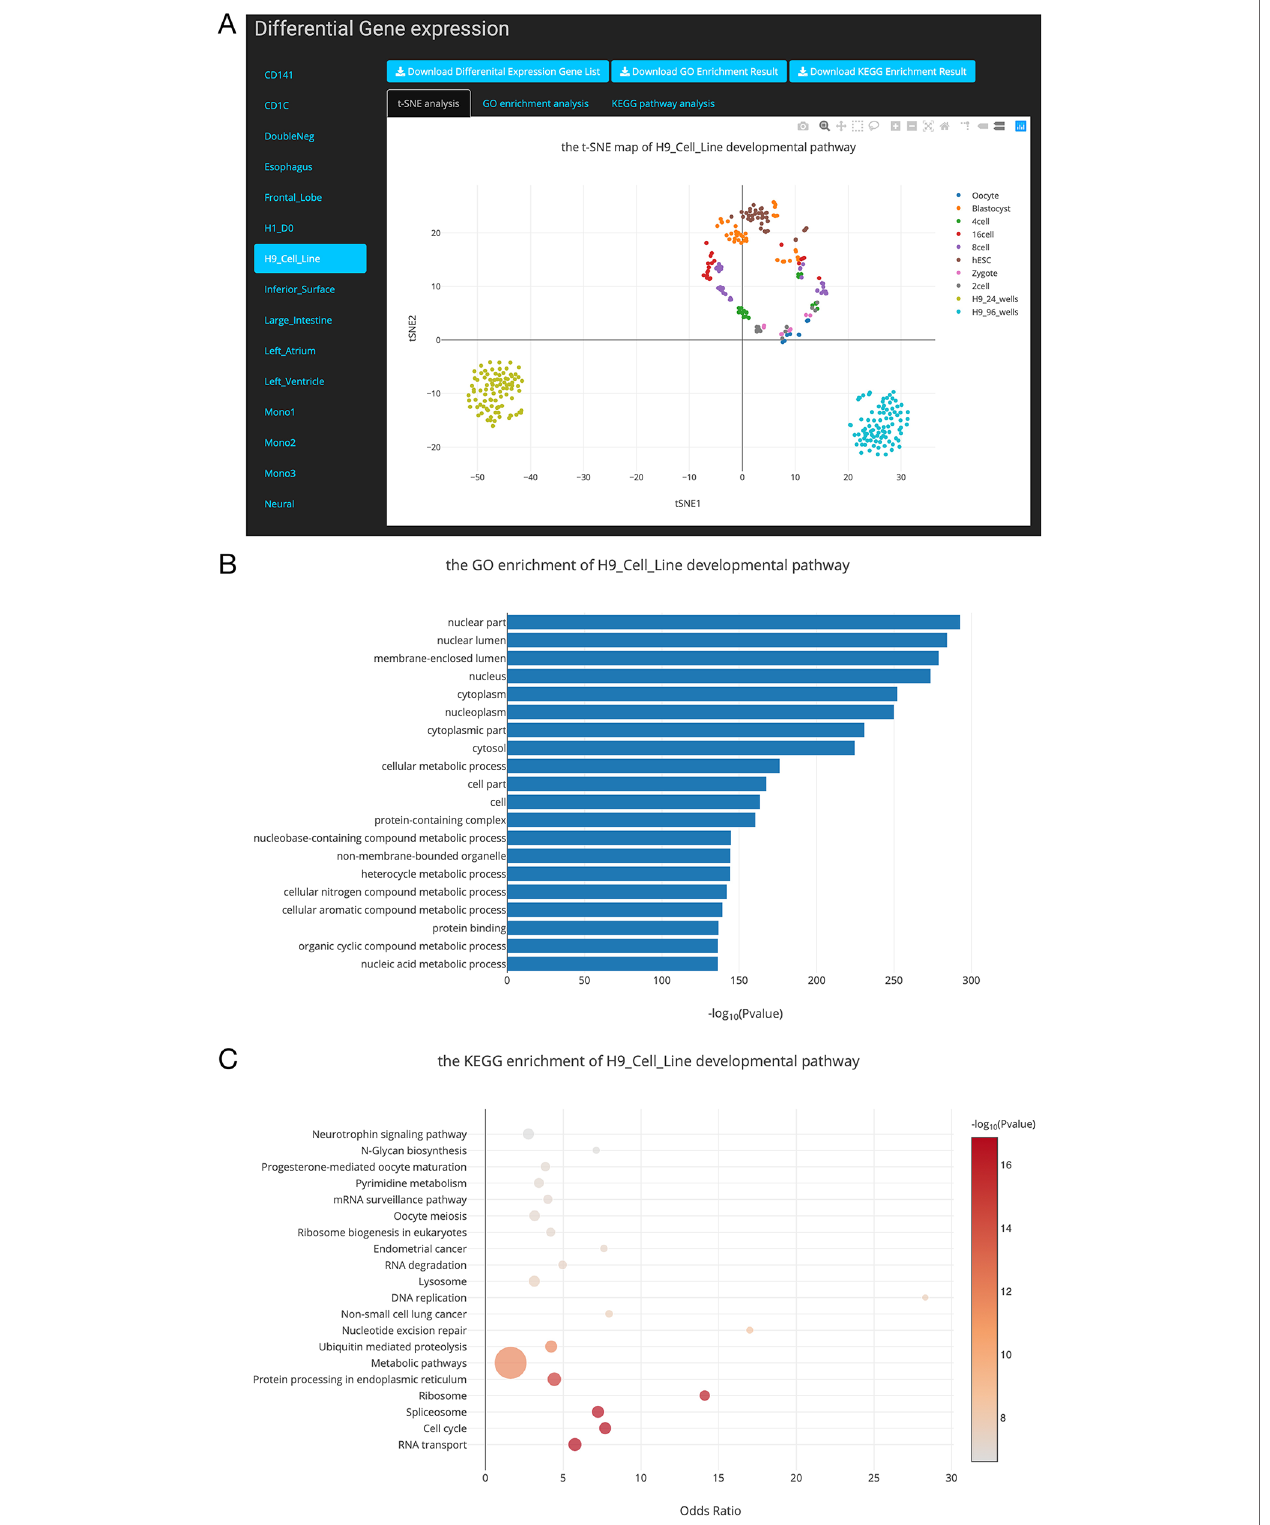
FIGURE 4 | Overview of the differential gene list collection page. (A) . T-distributed stochastic neighbor embedding (t-SNE) maps showing the relationships between developmental stages based on these differentially expressed genes. (B) . Top 20 Gene Ontology (GO) terms of differential expression genes. (C) . Top 20 Kyoto Encyclopedia of Genes and Genomes (KEGG) terms of differential expression